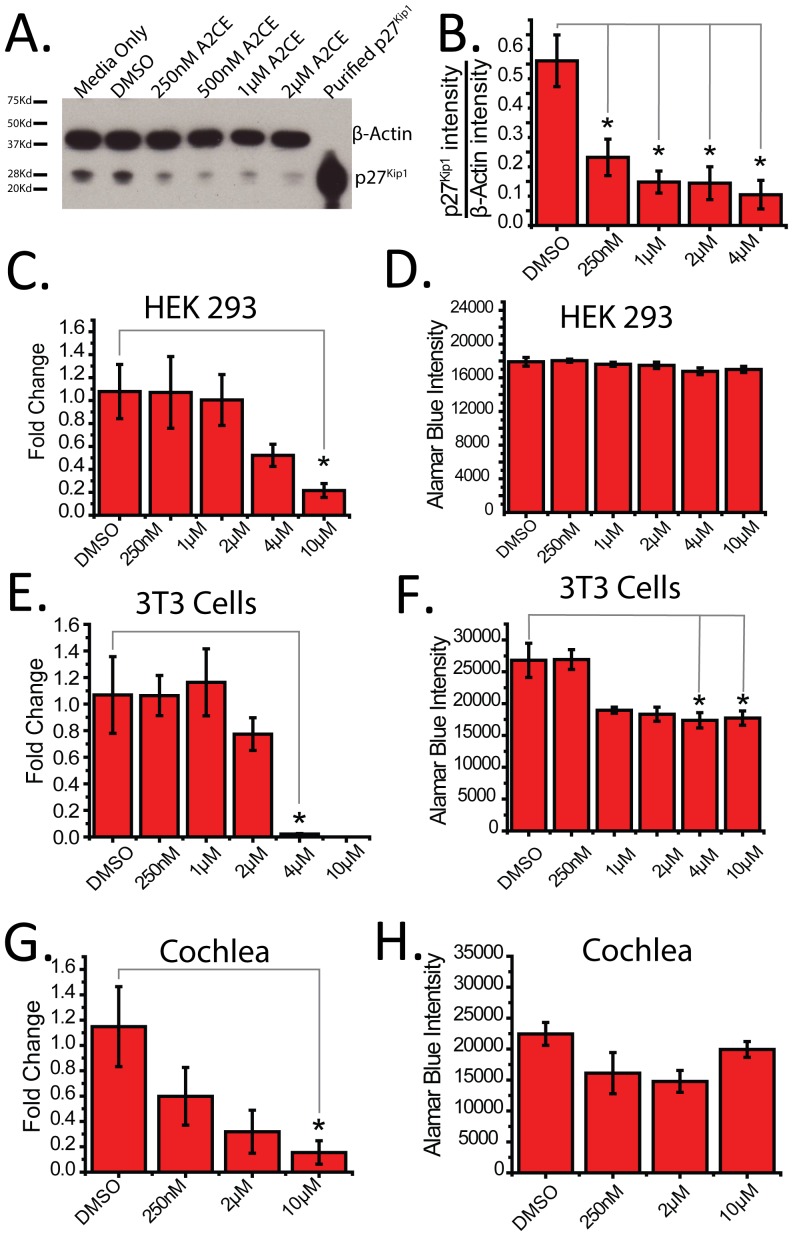
Alsterpaullone, 2-Cyanoethyl inhibits p27Kip1 transcription from diverse cellular origins, and reduces p27Kip1 protein levels.A. Immunoblot of p27Kip1 and β-actin with indicated concentration of A2CE in HeLa cells. B. Relative intensity of p27Kip1 normalized to β-actin by densitometry (n = 3) with indicated concentrations of A2CE. C. Fold changes of endogenous p27Kip1 mRNA (normalized to 18s) in HEK cells treated with indicated concentrations of A2CE normalized to DMSO (n = 3). D. Alamar blue cell viability assay in HEK cells treated with indicated concentrations of A2CE. E. Fold changes of endogenous p27Kip1 mRNA (normalized to 18s) in 3T3 cells treated with indicated concentrations of A2CE normalized to DMSO (n = 3). F. Alamar blue cell viability assay in 3T3 cells treated with indicated concentrations of A2CE G. Fold changes of endogenous p27Kip1 mRNA (normalized to 18s) in cochlear explants treated with indicated concentrations of A2CE normalized to DMSO (n = 3). H. Alamar blue cell viability assay in cochlear explants treated with indicated concentrations of A2CE. Mean ± S.E.M., * p<0.05 (One way ANOVA, followed by bonferroni for means comparison).